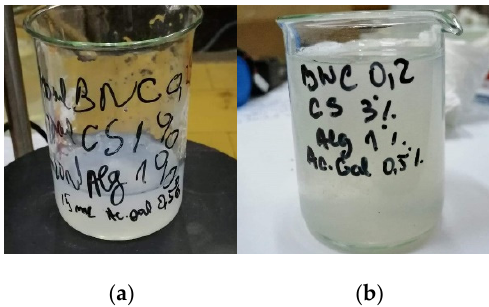
Figure 1. ( a ) Preparation of chitosan: gallic acid nanoparticles by ionotropic reticulation. ( b ) Stabilization of CS-GA system in an NDBNC-Alginate